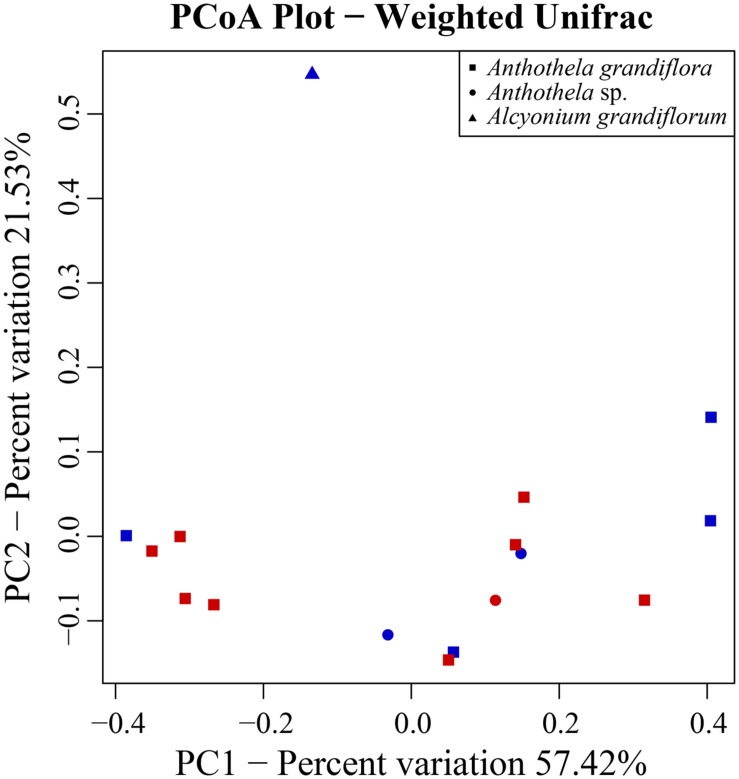
Principal coordinate analysis (PCoA) plot of weighted Unifrac distance. Principal coordinates analysis was used to plot the beta diversity of bacterial communities using the weighted Unifrac Matrix. Red symbols indicate samples collected from Baltimore Canyon, while blue symbols indicate samples collected from Norfolk Canyon. Symbol shapes defined in the legend distinguish the samples based on host genetic identification (e.g., A. grandiflora, Anthothela sp., and Al. grandiflorum).